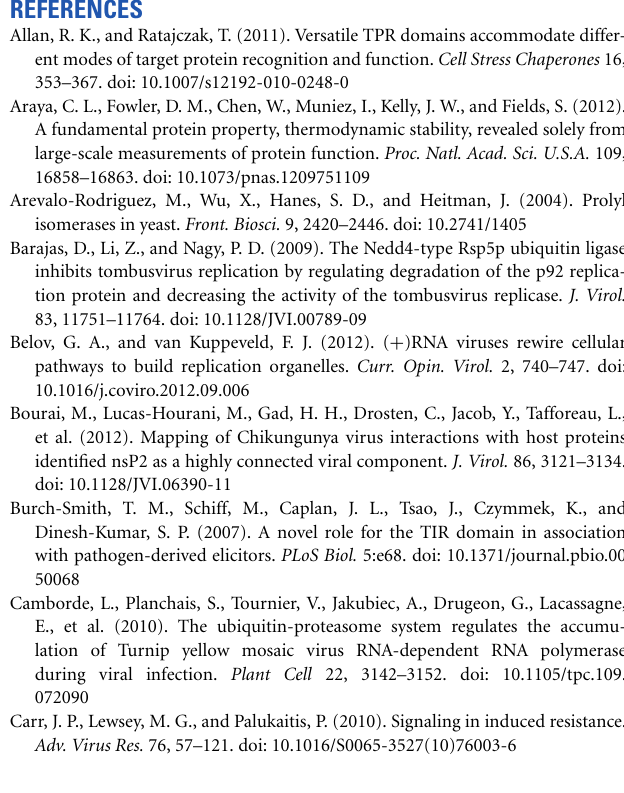
the most important interactions common to S. cerevisiae and A. thaliana. In panel (A) , the Arabidopsis orthologs include DBP3 (STRS1), DED1 (AT3G58510), NSR1 (ATNUC-L), and CDC33 (EIF4E), panel (B) shows the conserved interactions between Hsp70 family proteins and ACT1 (ACT11), TUB4 (TUBG1), COF1 (ADF6), and SKP1 (ASK2) orthologs, while panel (C) indicates the conserved interactions between GAPDH genes and POL1 (ICU2) and PRI1 (POLA3)